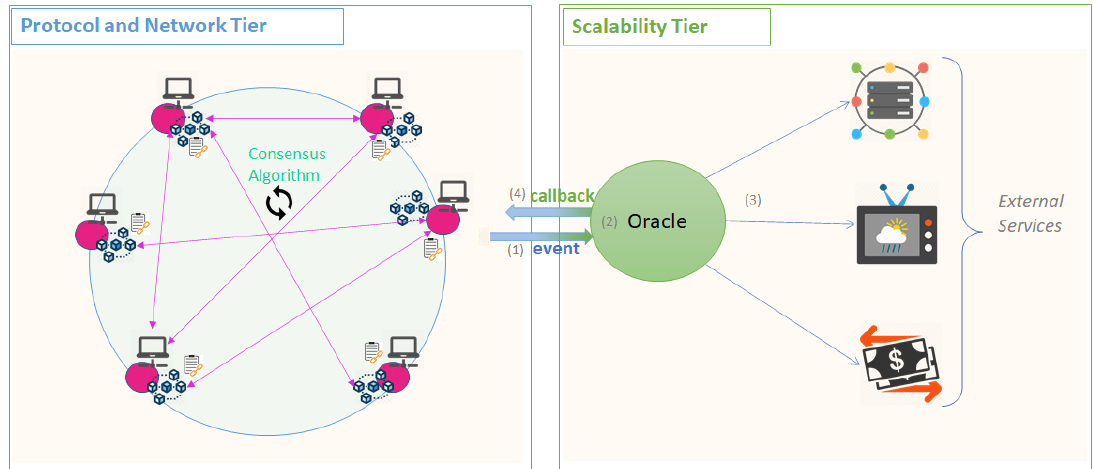
Figure 6. Scalability Tier—Oracle for External Services Integration.